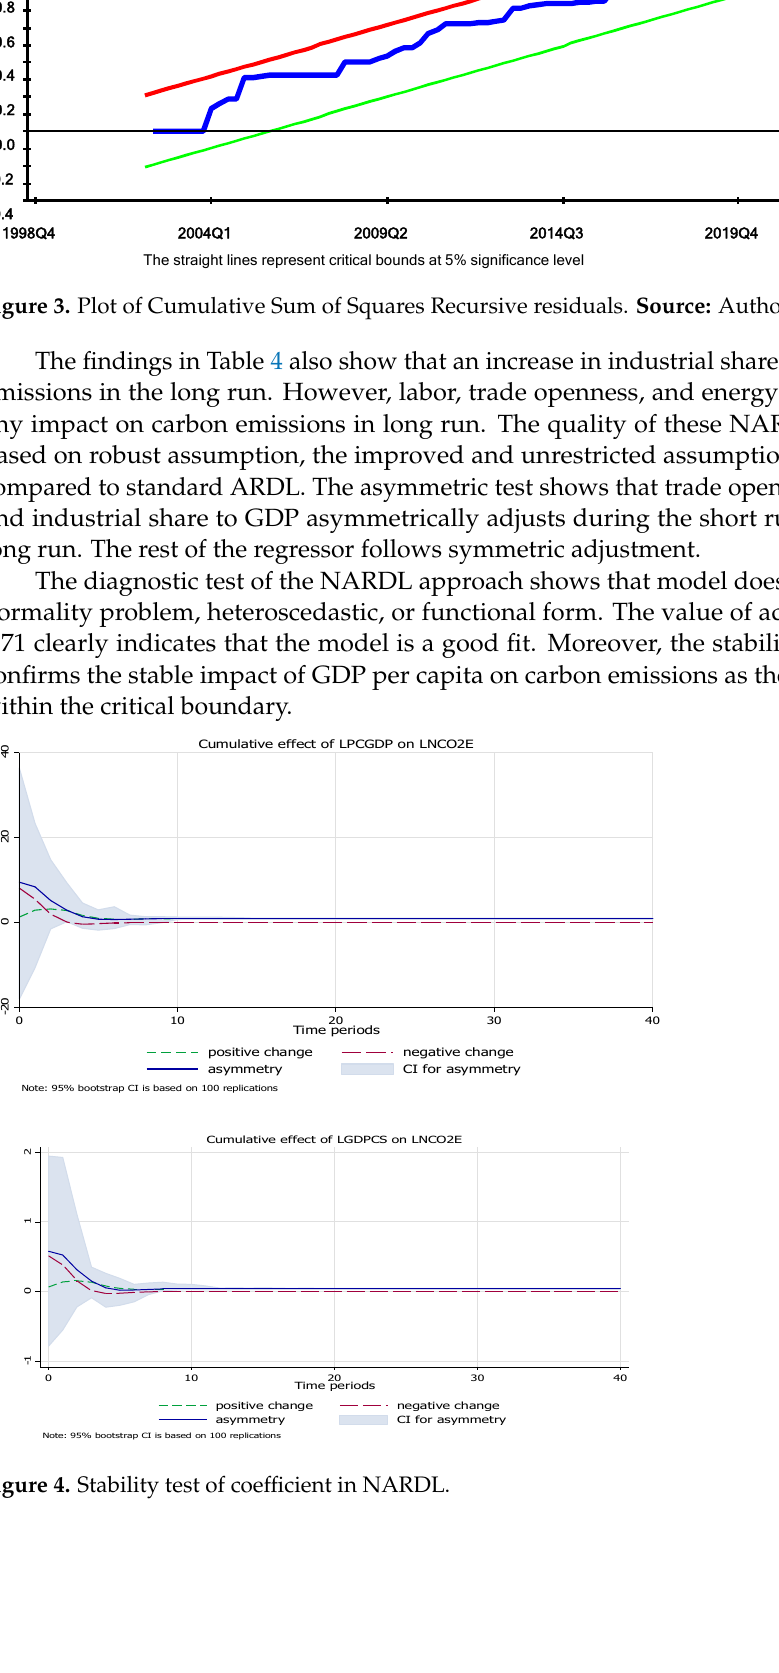
Figure 2. Plot of Cumulative Sum of Recursive Residuals. Source: Author’s Calculation.